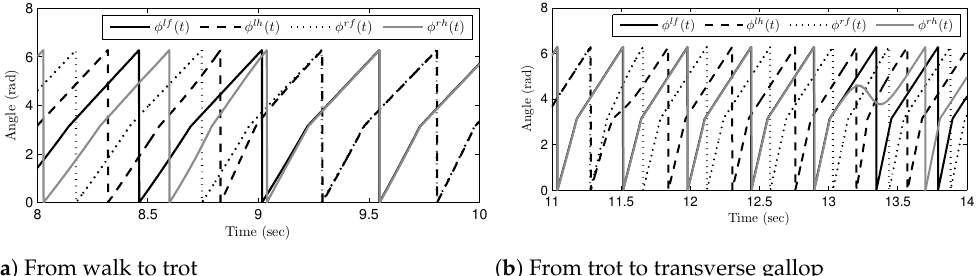
Figure 15. Indexes on the scaled gait cycle domain during gait phase transitions: ( a ) transitions from the walk phase to the trot phase and ( b ) transitions from the trot phase to the transverse gallop phase0.